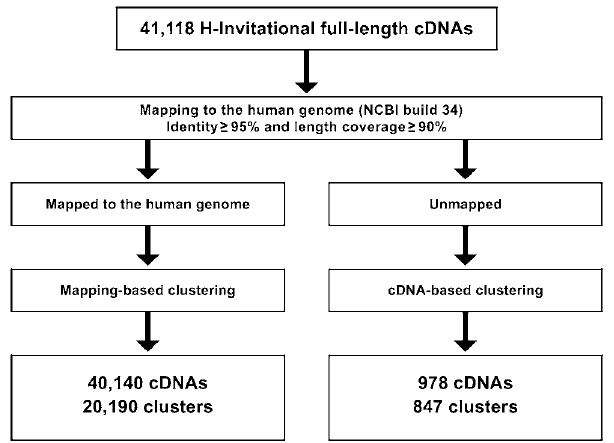
Figure 1. Procedure for Mapping and Clustering the H-Inv cDNAs The cDNAs were mapped to the genome and clustered into loci. The remaining unmapped cDNAs were clustered based upon the group- ing of significantly similar cDNAs. DOI: